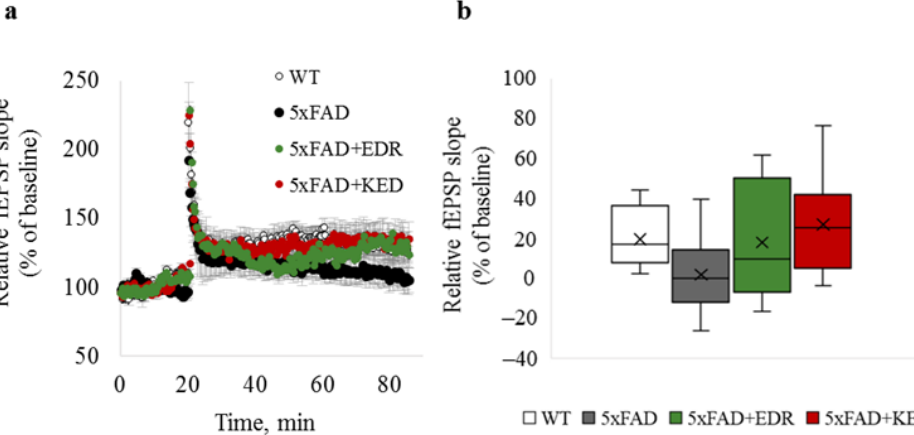
Figure 1. LTP in hippocampal brain slices of WT (white) and 5xFAD mice injected with a physiological solution (black), EDR peptide (green) and KED peptide (red). ( a ) Time course of fEPSP slope 20 min before and 60 min after LTP induction; ( b ) box plot illustrating plasticity value estimated by a relative fEPSP slope 50 min after LTP induction. The middle bar in the boxes represents the median; the cross in the boxes represents the mean; the lower and upper ends of the boxes represent the first and third quartiles, respectively. “Whiskers” represent values within 1.5 times the interquartile range from the upper and lower quartile.